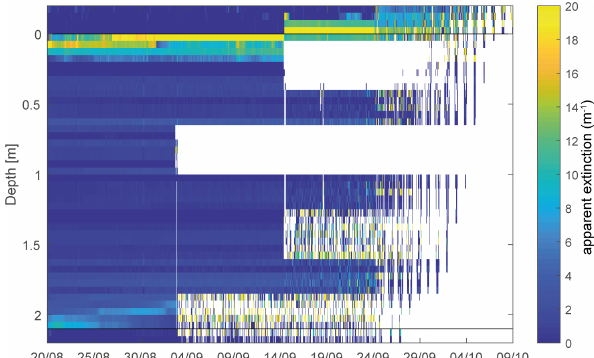
Figure 6. Vertical profiles of apparent extinction coefficients calcu- lated from light chain data. Black lines indicate the interfaces be- tween air, ice and ocean during chain